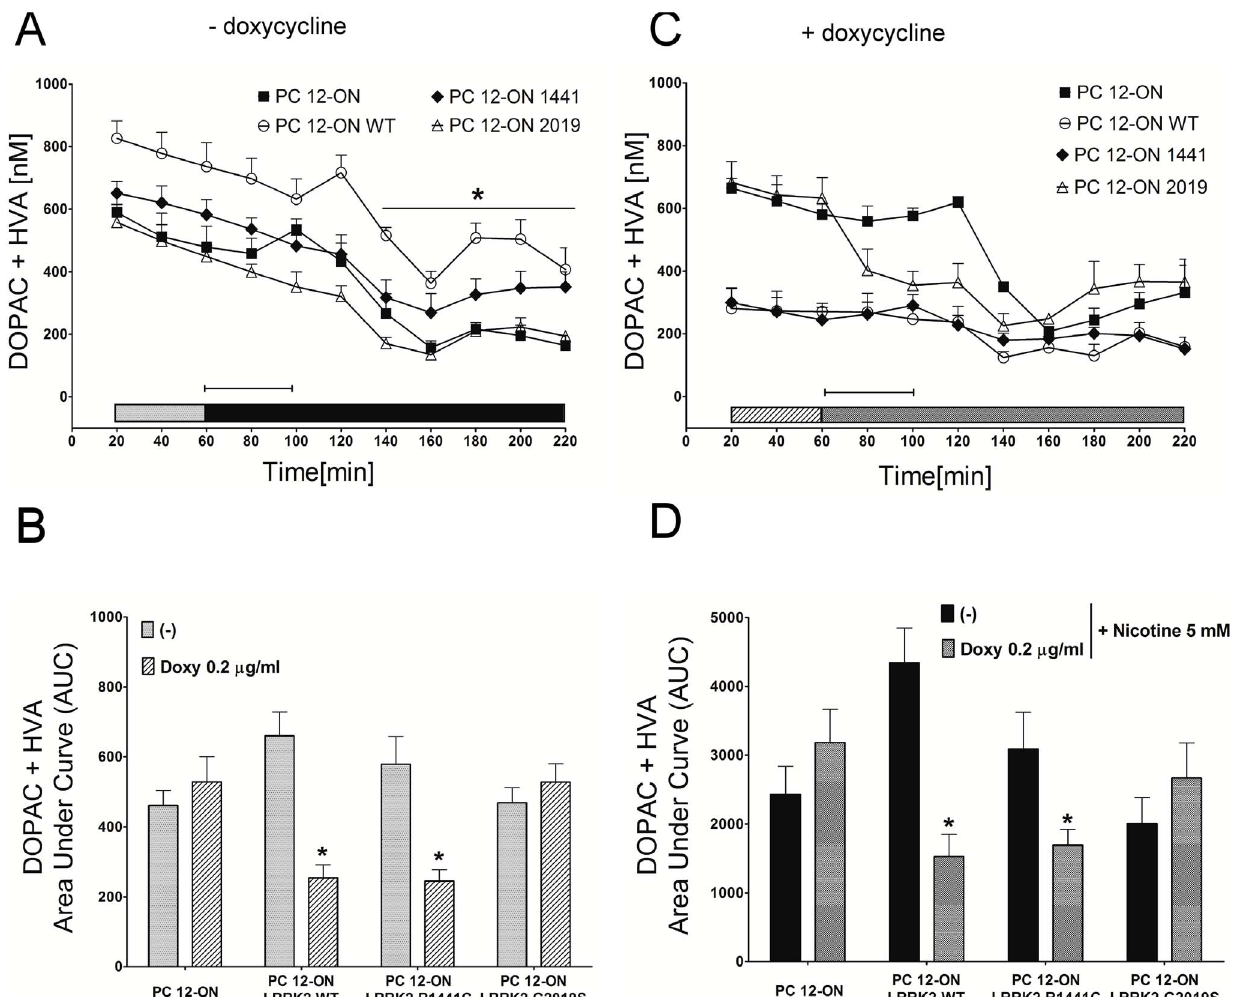
Figure 3. Effect LRRK2 expression on DOPAC + HVA concentrations. PC12-derived cell lines were left untreated (A) or treated (C) for 48 h with 0.2 m g/ml doxycycline. After 60 minutes of stabilization, three baseline dialysates were collected at 20-minute intervals [bars in panel (A), and gray bars with stripes in panel (C)]. Starting from 60 minutes, nicotine was infused for 60 minutes (capped lines). Microdialysates were continuously recovered during drug infusion and after nicotine discontinuation [black bars in panel (A), and dotted bars in panel (C)]. Values are mean 6 SEM and refer to DOPAC + HVA concentrations in dialysates. Statistical significance was assessed using analysis of variance (ANOVA) for differences over time determined by Newman-Keules t test and unpaired t -tests. * p , 0.05 compared with pertinent baseline values of all groups. Graphs in panel (B) and (D) represent the area under curve (AUC) values. (B) Basal DOPAC + HVA concentration in dialysates of PC12 cell lines untreated [bars corresponding to the same color in panel (A)] or treated with 0.2 m g/mL doxycycline [bars with stripes corresponding to the same color in panel (C)]. (D) DOPAC + HVA concentrations in dialysates integrated after nicotine administration in PC12 cell lines untreated [black bars corresponding to the same color in panel (A)] or treated with 0.2 m g/ml doxycycline [dotted bars corresponding to the same color in panel (C)]. AUC values are mean 6 SEM. * p , 0.05 vs corresponding control. doi:10.1371/journal.pone.0077198.g003 Under the same experimental conditions, the GSK2578215A GSK2578215A on PC12-ON or PC12-ON expressing the inhibitor does not affect the concentration of DOPAC + HVA LRRK2 G2019S . The presence of LRRK2 inhibitor does not (Figure S1). influence the DA extracellular level in basal conditions (20–40– 60 minutes in figure 4A vs B or the relative AUC in Figure 4C) Vesicle Distribution in PC12 Cells Expressing LRRK2 G2019S in both cellular types. In presence of nicotine, the inhibitor does not affect the expected increase in DA extracellular level in Pathological Mutant PC12-ON cells while it determines a reduction in PC12-ON Given the dopamine secretion changes associated with LRRK2 expressing the LRRK2 G2019S mutant although this DA extra- expression, we asked whether LRRK2 might be involved in cellular level decrease does not rich statistical significance in synaptic vesicle (SV) movement/distribution. Using an electron three independent experiments (Figure 4A from 60 to 220 microscopy approach we analysed the vesicles distribution in minutes vs 4B from 60 to 220 minutes and the relative AUC in PC12-ON or PC12-ON-LRRK2 G2019S cell lines. Expression was Figure 4D). induced for 24 hours with 0.2 m g/mL doxycycline and cells were quickly fixed for electron microscopy. Non-induced cells served as